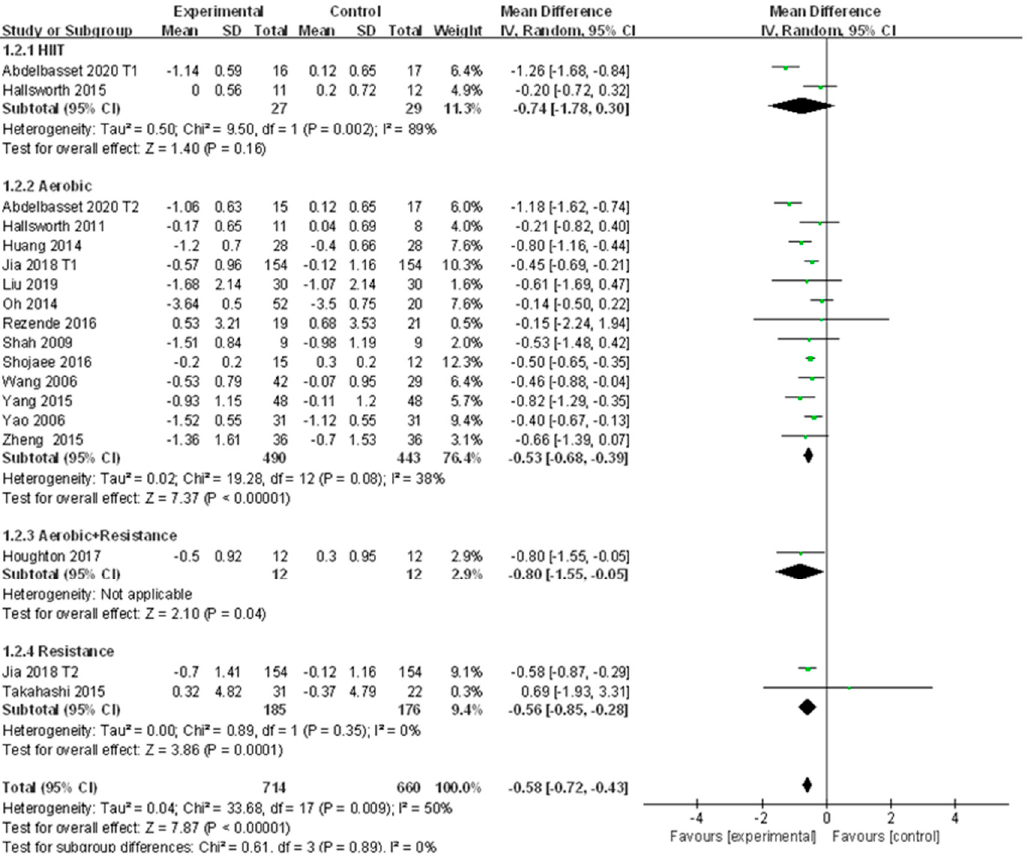
Figure 3. Subgroup analysis of different exercise styles on triglycerides (TG).